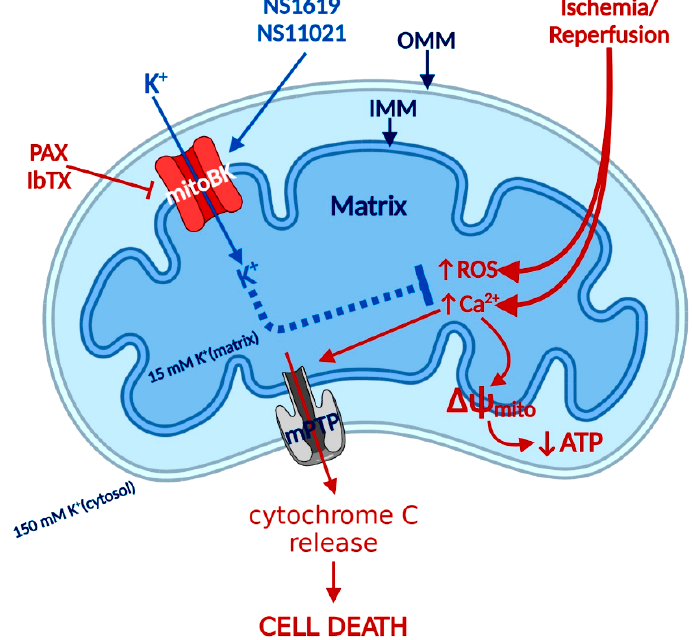
Figure 1. BK Ca signaling in cardiomyocytes mitochondria during ischemia-reperfusion (I / R) injury. I / R injury causes an increase of reactive oxygen species (ROS) production and Ca 2 + overload that leads to mPTP opening, the collapse of membrane potential ( ∆Ψ IMM ), and the release of cytochrome C that causes cell death. The opening of BK Ca protects the heart by reducing ROS and increasing the calcium retention capacity, hence delaying the opening of mPTP. IMM—Inner mitochondria membrane, OMM—Outer mitochondria membrane. mitoBK Ca activators (NS1619, NS11021), mitoBK Ca inhibitors (PAX-paxilline, IbTX-iberiotoxin), mPTP-mitochondrial permeability transition